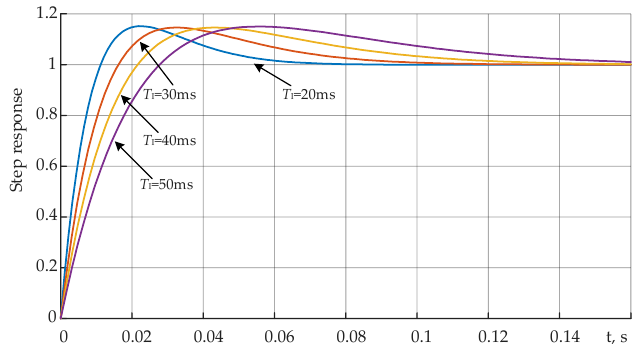
Figure 11. Step responses of the dc link voltage for different integrating times T I and the damping factor ξ = 1